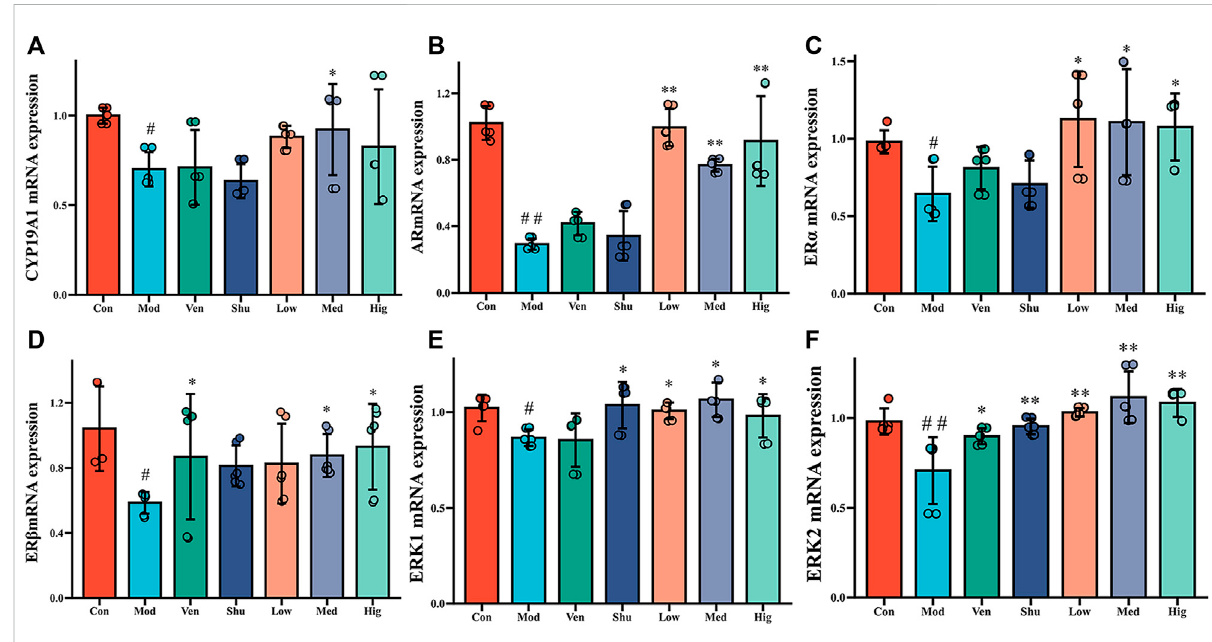
FIGURE 4 The effect of Chaigui granule on mRNA expression of CYP19A1-E2-ERK1/ERK2 pathway in the hippocampus. (A) The expression of CYP19A1 mRNA in the hippocampus. (B) The expression of AR mRNA in the hippocampus. (C) The expression of ER α mRNA in the hippocampus. (D) The expression of ER β mRNA in the hippocampus. (E) The expression of ERK1 mRNA in the hippocampus. (F) The expression of ERK2 mRNA in the hippocampus. All data were expressed as mean ± SD. # p < 0.05, ## p < 0.01 compared with Control group. ✻ p < 0.05, ✻✻ p < 0.01 compared with Model group.